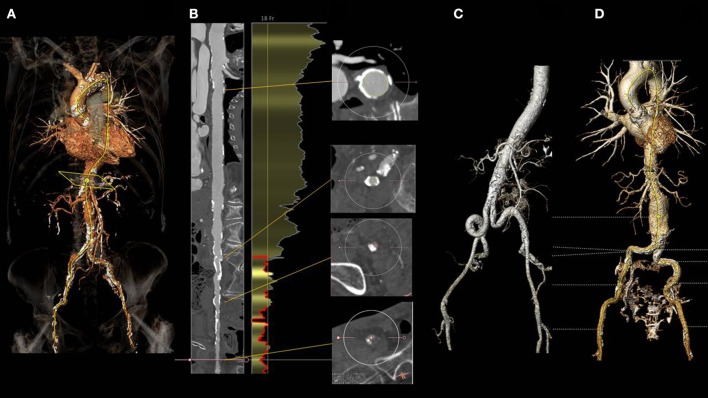
Three dimensional angio CT reconstruction obtained with the 3mensio software in a patient with severe aortic stenosis referred for TAVI (A). Snake view of the aorta and right iliacofemoral arteries (B) clearly shows diffuse calcific atherosclerotic disease precluding trans-femoral route. (C) shows diffuse tortuosity of the iliac arteries, while (D) the incidental finding of an infrarenal abdominal aneurysm. All the above mentioned findings might preclude a transfemoral approach.